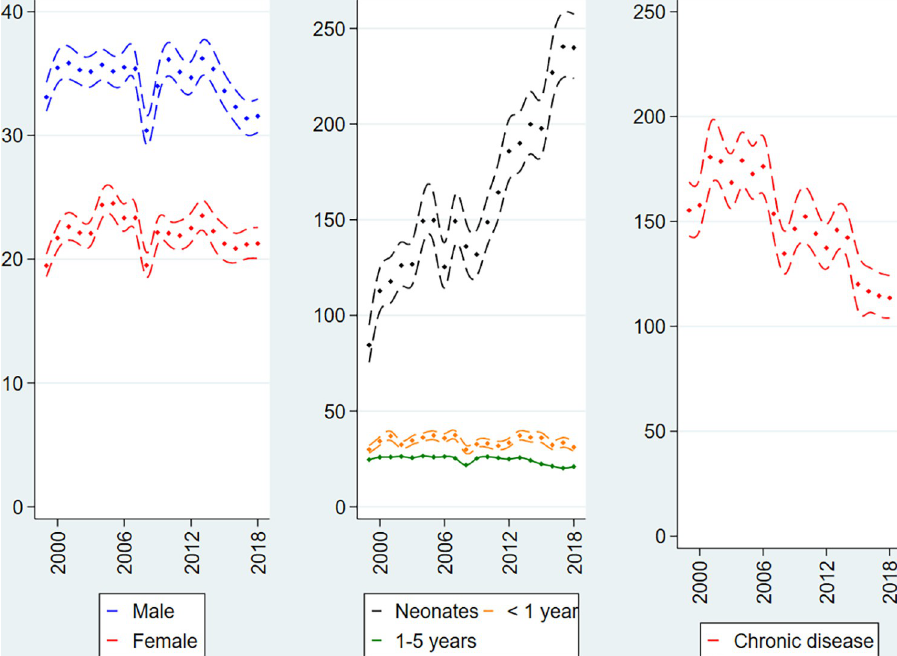
Fig 2. Overall rates of surgical procedures in public hospitals per 1000 person-years, Danish children 0–5 years of age, 1999–2018. Sex-specific incidence (left panel), age-specific incidence (middle panel) and chronic disease-specific incidence (right panel) with 95% pointwise confidence